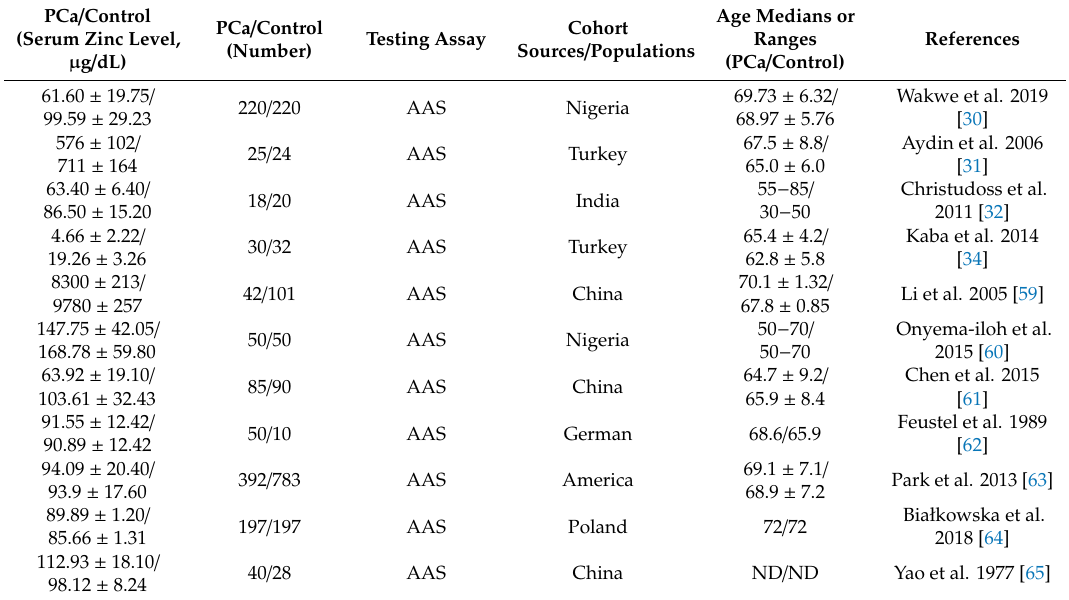
Table 1. Summary of reports comparing serum zinc levels between PCa patients and healthy